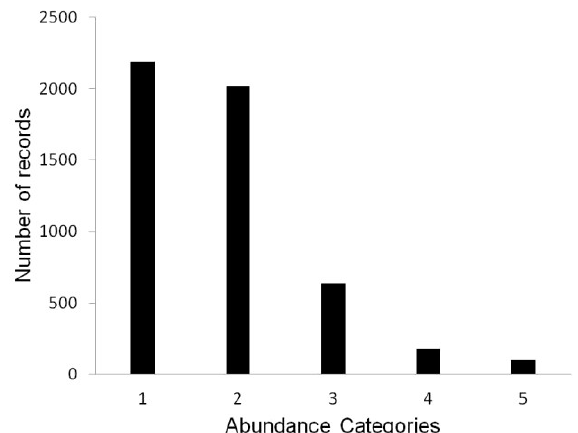
Figure 3. Local abundance patterns in Republic of the Marshall Islands (RMI) coral communities. Histogram of the frequency of occurrence of the five abundance categories (per 2,500 m 2 ) where: Category 1 = 1–2 colonies i.e. , rare; Category 2 = 3–5 colonies i.e. , infrequent; Category 3 = 6–20 colonies i.e. , frequent; Category 4 = 21–50 colonies i.e. , common; Category 6 = 51 + colonies i.e. ,